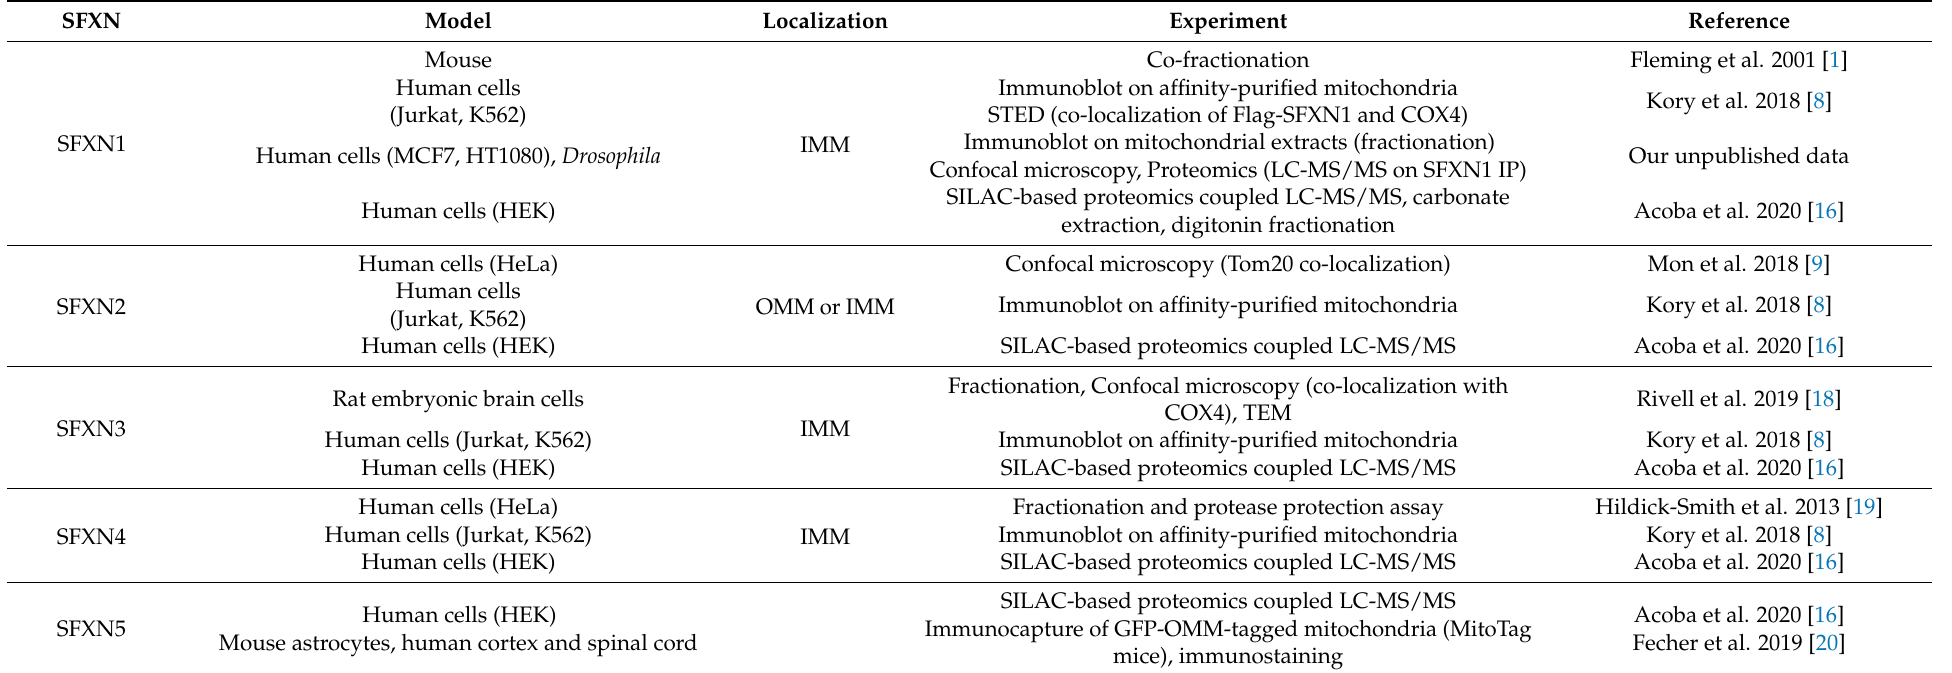
Table 1. Evidence for a mitochondrial localization of